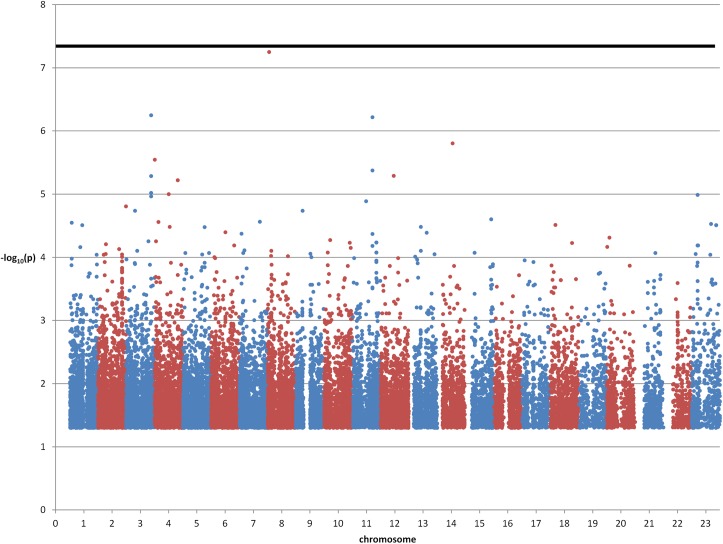
Manhattan plot of severe vs. mild influenza cases. Only p-values < 0.05 are shown. The thick horizontal line denotes p = 5×10−8.